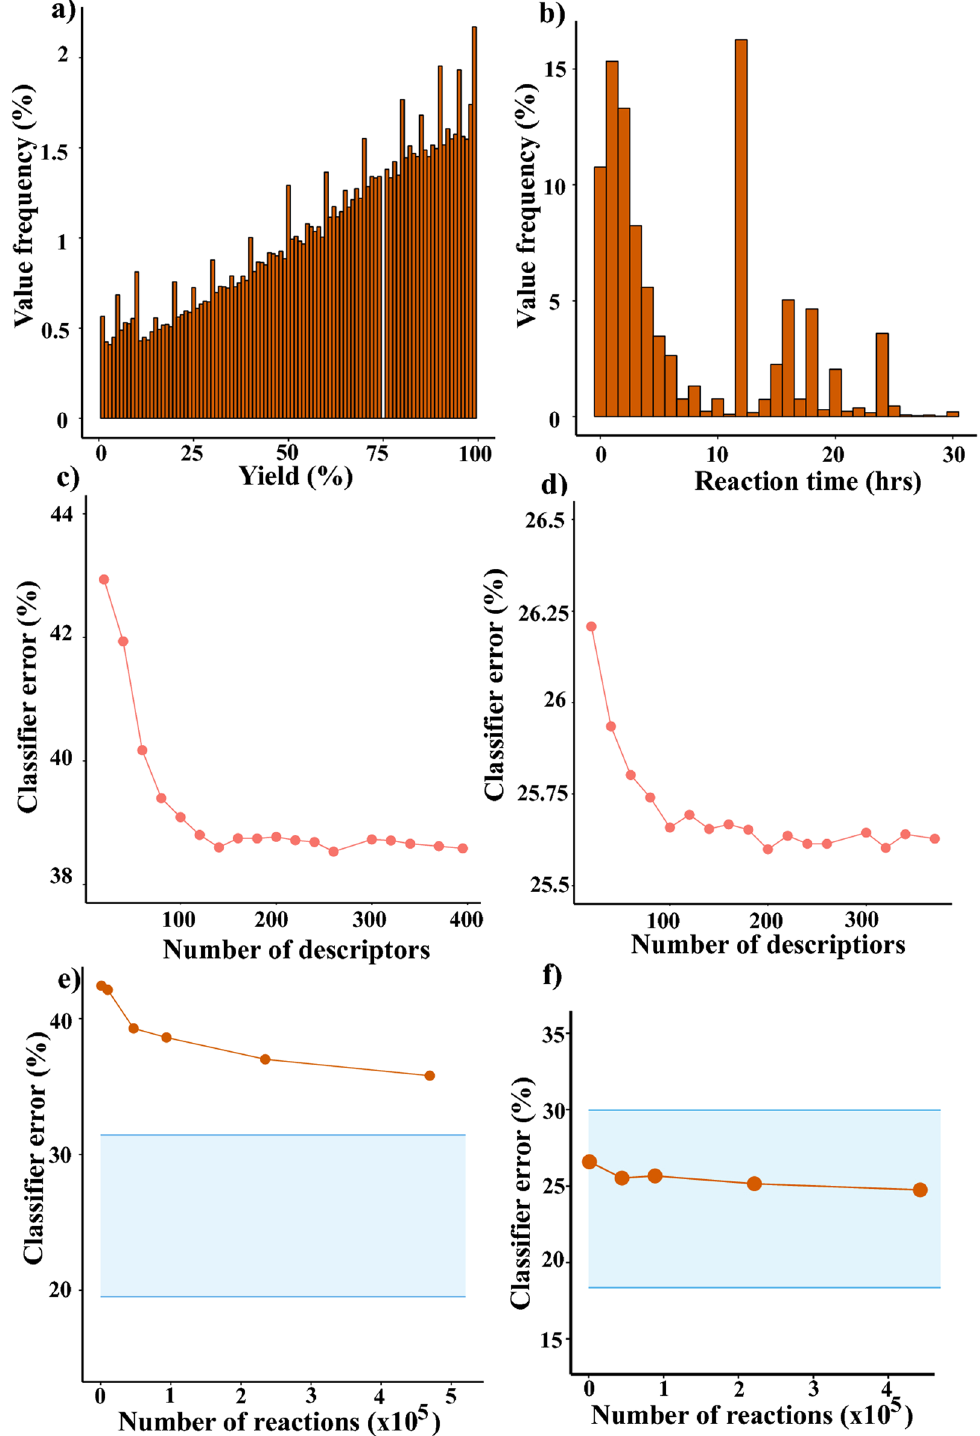
Figure 3. Yield and time predictions based on molecular descriptors. Histograms with distribution of ( a ) yields ( b ) reaction times. Classifier errors plotted as a function of the number of RDKit descriptors for ( c ) yields and ( d ) reaction times. The errors stabilize above c.a. 100 descriptors. Similar analysis (i.e., with classifiers built on descriptors) for different sizes of the reaction sets evidences that errors (both for yields ( e ) and ( f ) times) do not significantly decrease for larger datasets. Shaded, blue regions in panels ( e ) and ( f ) demarcate lower and upper estimates for the Bayes classifier error (i.e. the best classifier that can be used to discriminate between these datasets, see SI for theoretical